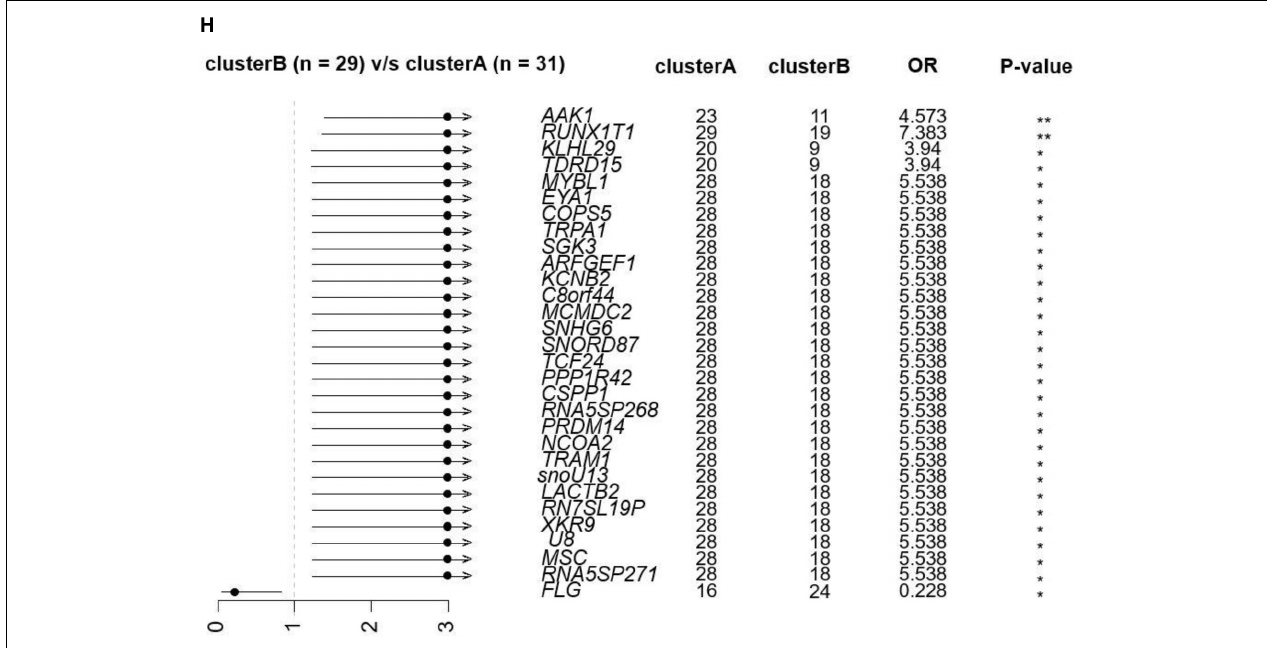
FIGURE 3 | (A) The volcano plot demonstrates the DEGs of clusters A and B. (B) Unsupervised clustering of 44 ESCC patients from TCGA and TMCA. Clinical-pathologic characteristics contain age, stage, smoking, and cluster groups. (C) The waterfall plots demonstrate the proportion of genomic mutations and certain types of mutations in cluster I. (D) Detailed somatic genomic mutations and variations of copy number analysis of cluster I. (E) The waterfall plots demonstrating the proportion of genomic mutations and certain types of mutations in cluster II. (F) Detailed somatic genomic mutations and variations of copy number analysis of cluster II. (G) The waterfall plots demonstrate the genomic alterations including somatic genomic mutations and variations of copy number in the two cluster cohorts. (H) The forest plot shows the value of each co-related genome of prognosis by corresponding hazard ratio (HR) and Odds ratio with 95%